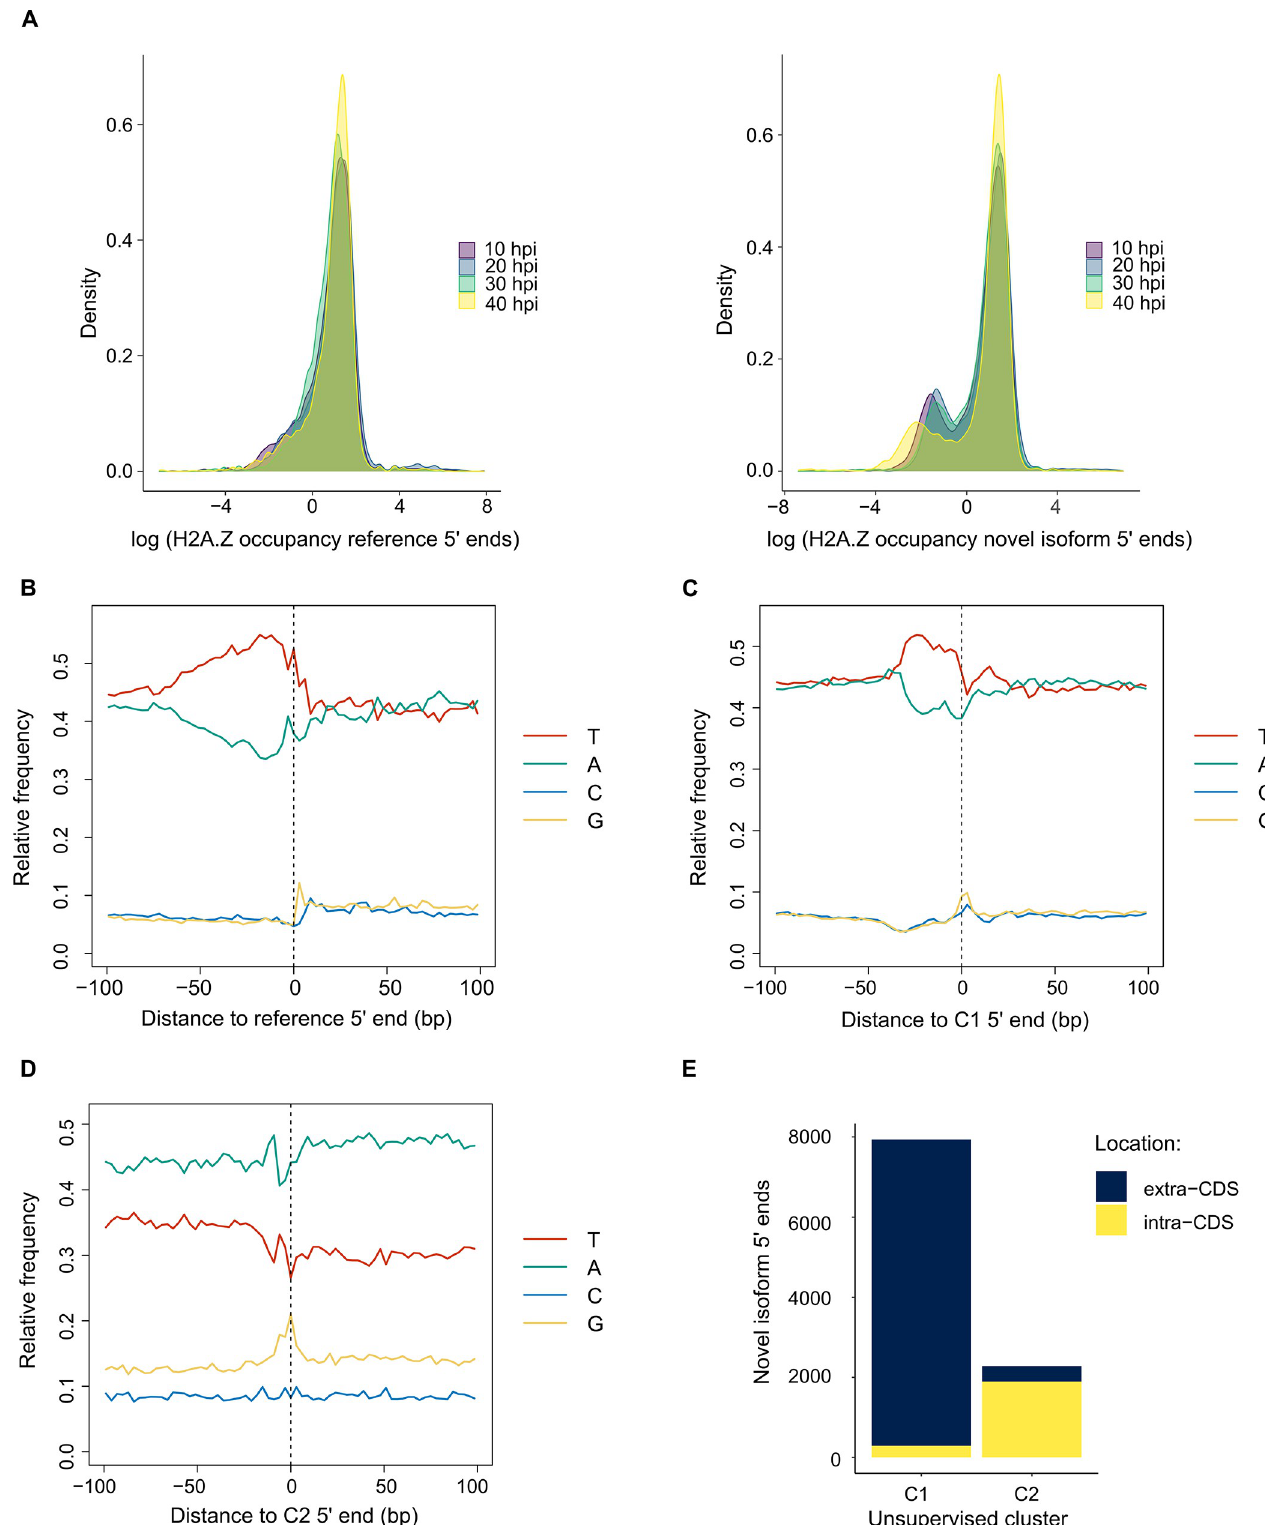
Fig 3. Analysis of transcript 5 0 ends. Genomic analysis of unique 5 0 ends for Plasmodium falciparum 3D7 reference transcripts (5,561 positions) and novel isoforms (10,323 positions). (A) Distribution of natural log normalized H2A.Z histone occupancy [32] of reference transcripts (left) and novel isoforms